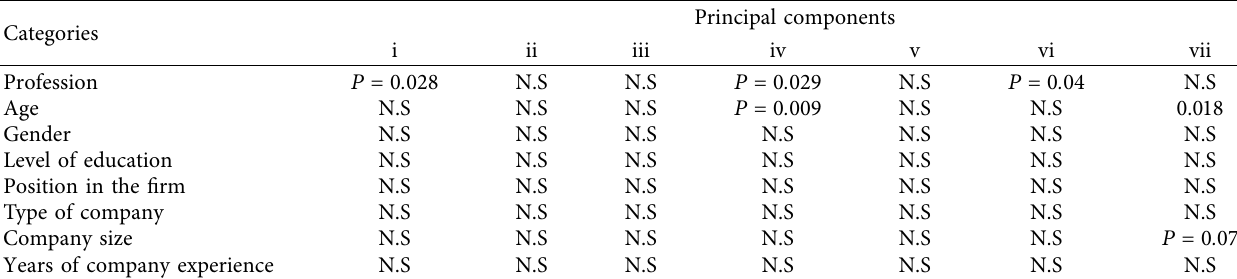
Table 6: Summary of ANOVA